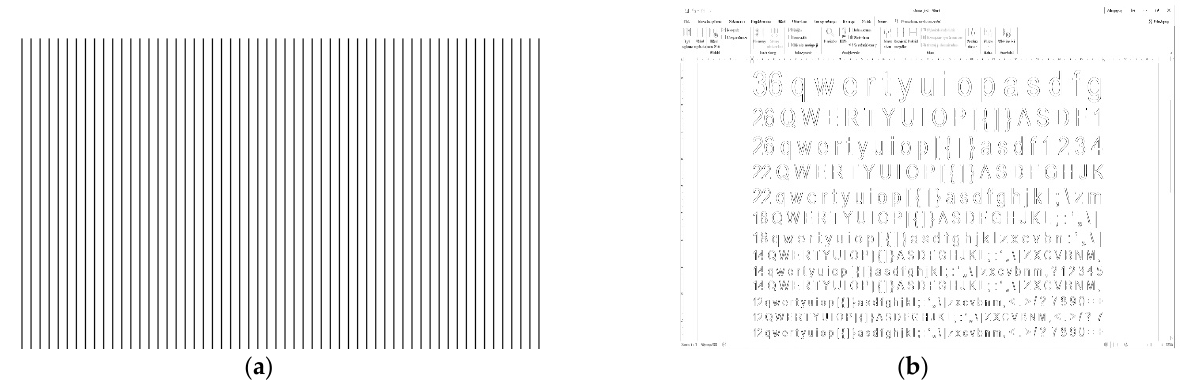
Figure 8. Rasterized images on base on test signals obtained from the BMP file after the differentia- tion operation: ( a ) strips 8 × 8 pixels-fragment, ( b ) window of MS Word editor. operation: ( a ) strips 8 × 8 pixels-fragment, ( b ) window of MS Word